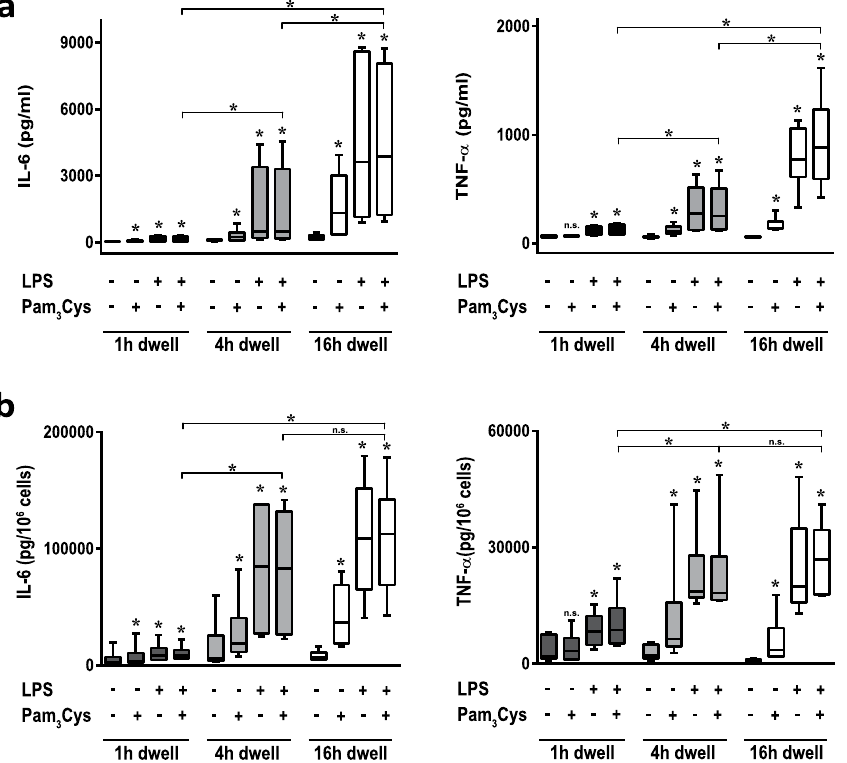
Figure 3. Ex-vivo stimulation assay in effluents of different PET dwell times. ( a ) Levels of IL-6 (left) and TNF- α (right) in 9 ml effluent samples of the indicated dwell times, after direct ex-vivo stimulation by LPS and/ or Pam 3 Cys (100 ng/ml as indicated) for 24 h at 37 °C. Effluents from 6 patients of the randomized controlled trial without AlaGln supplementation. IL-6 and TNF- α release after maximum stimulation differed at all dwell times ( * p < 0.05 vs. control per dwell time) ( b ) Measured cytokine levels as normalized per 10 6 cells. IL-6 and TNF- α release were significantly higher at all dwell times (1, 4 and 16 h) after maximum stimulation with 100 ng/ml LPS plus 100 ng/ml Pam3Cys ( * p < 0.05 vs. control per dwell time). After normalization for peritoneal cell count the difference between the 1 h dwell and the 4 h and 16 h dwells was significant ( * p < 0.05), whereas cytokine release values at 4 h and 16 h were indistinguishable. Wilcoxon matched-pairs signed rank test was used to calculate p